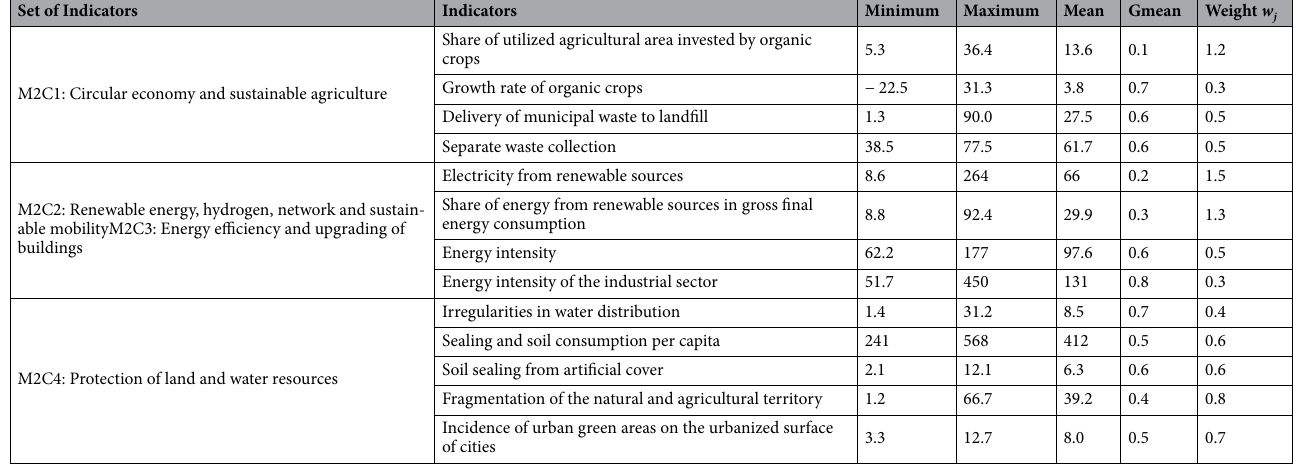
Table 6. Results of the application of the TFR method in relation to the distribution function and the weights of the different indices. Source : our elaboration on SDGs.